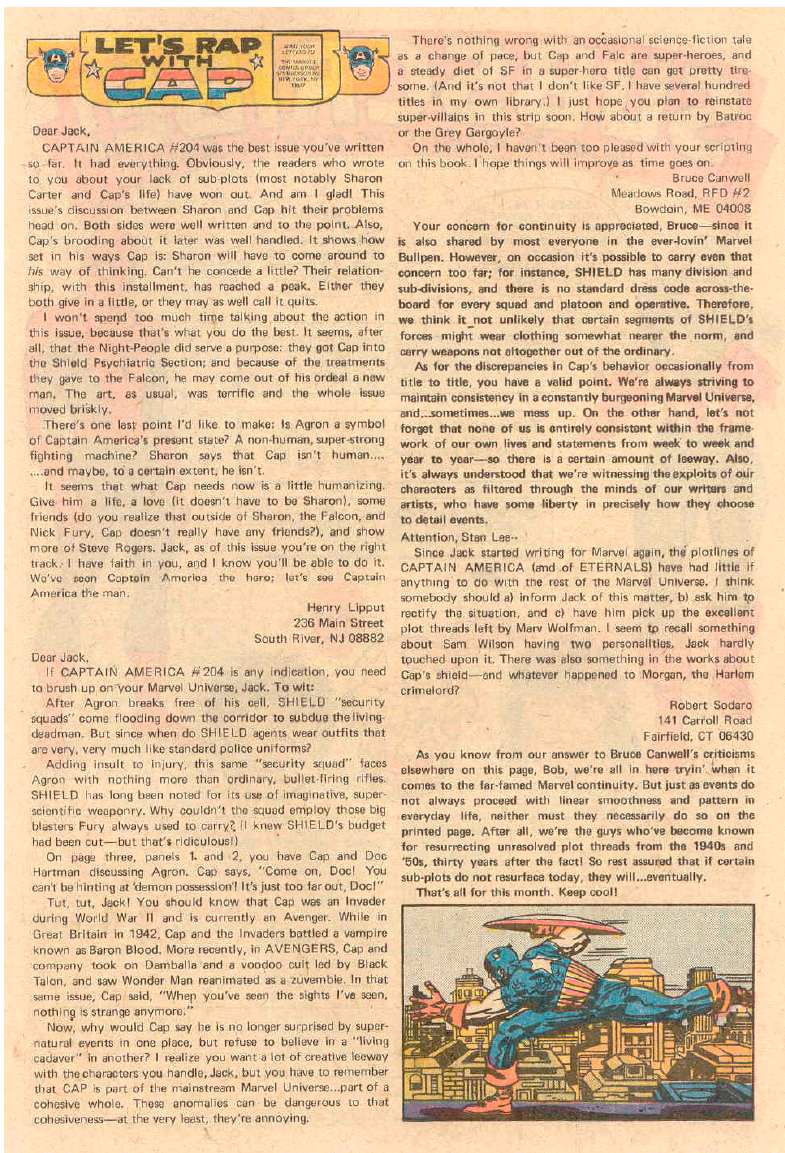
Figure 1. “Let’s Rap with Cap” letter column, Captain America #208 (April 1977).